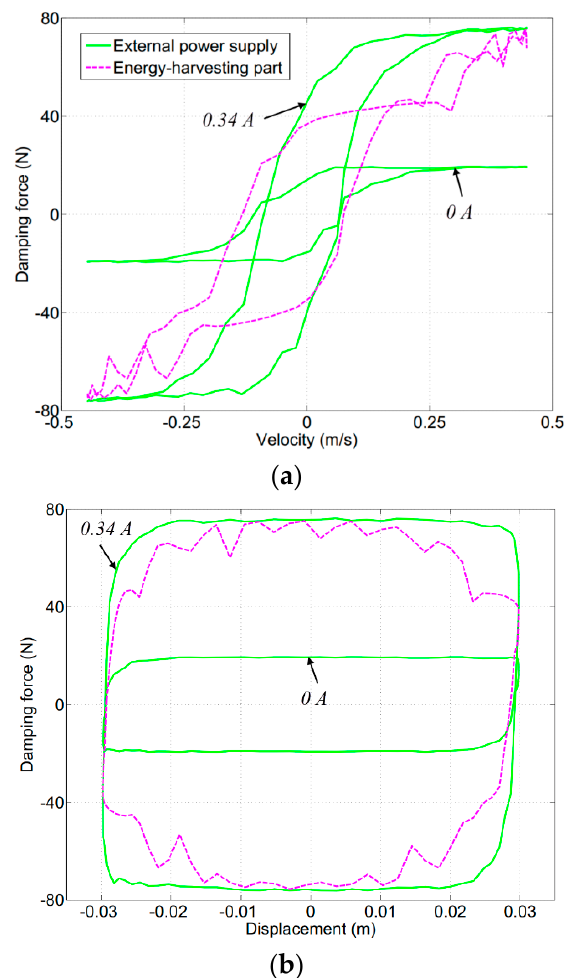
Figure 16. Experimental results of the MR damper with the energy-harvesting (EH) part and under constant external currents in the case when the excitation is 2.4 Hz frequency and 30 mm amplitude: ( a ) force vs. velocity and ( b ) force vs. displacement.